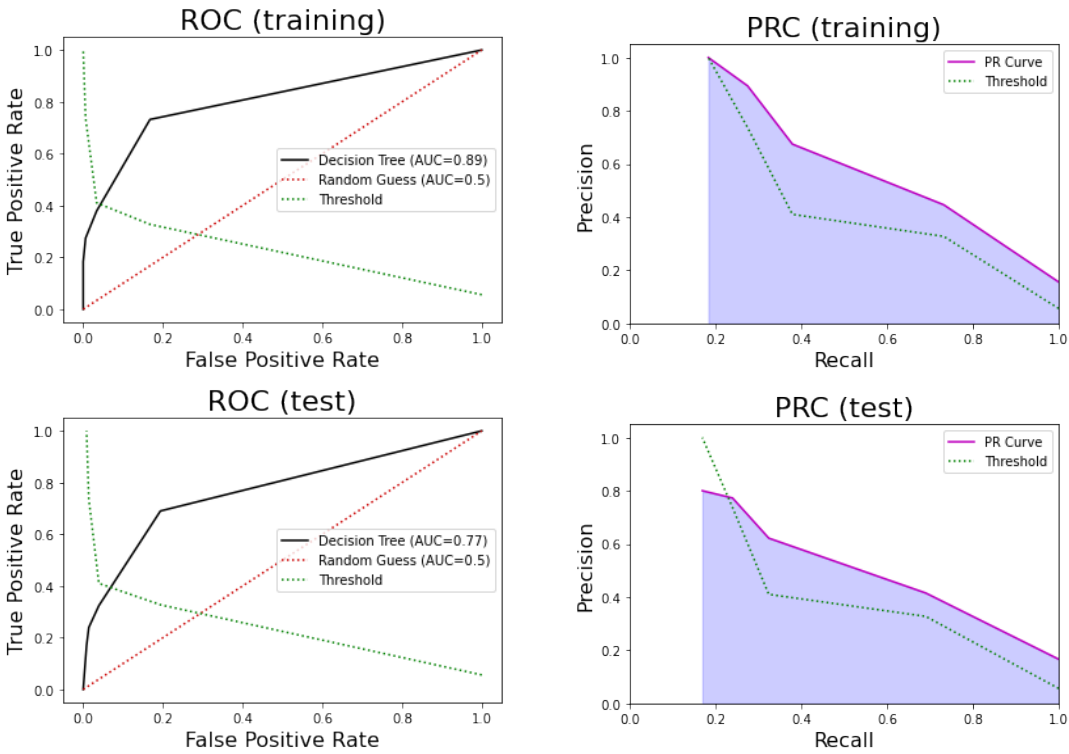
Figure 5. ( Top ) Receiver Operating Curve (ROC) for the decision tree model in training ( left ) and Figure 5. Top: Receiver Operating Curve (ROC) for the Decision Tree model in training (left) and test testing ( right ). ( Bottom ) Precision-Recall Curve (PRC) in training ( left ) and testing ( right (right). Bottom: Precision-Recall Curve (PRC) in training (left) and test (right).